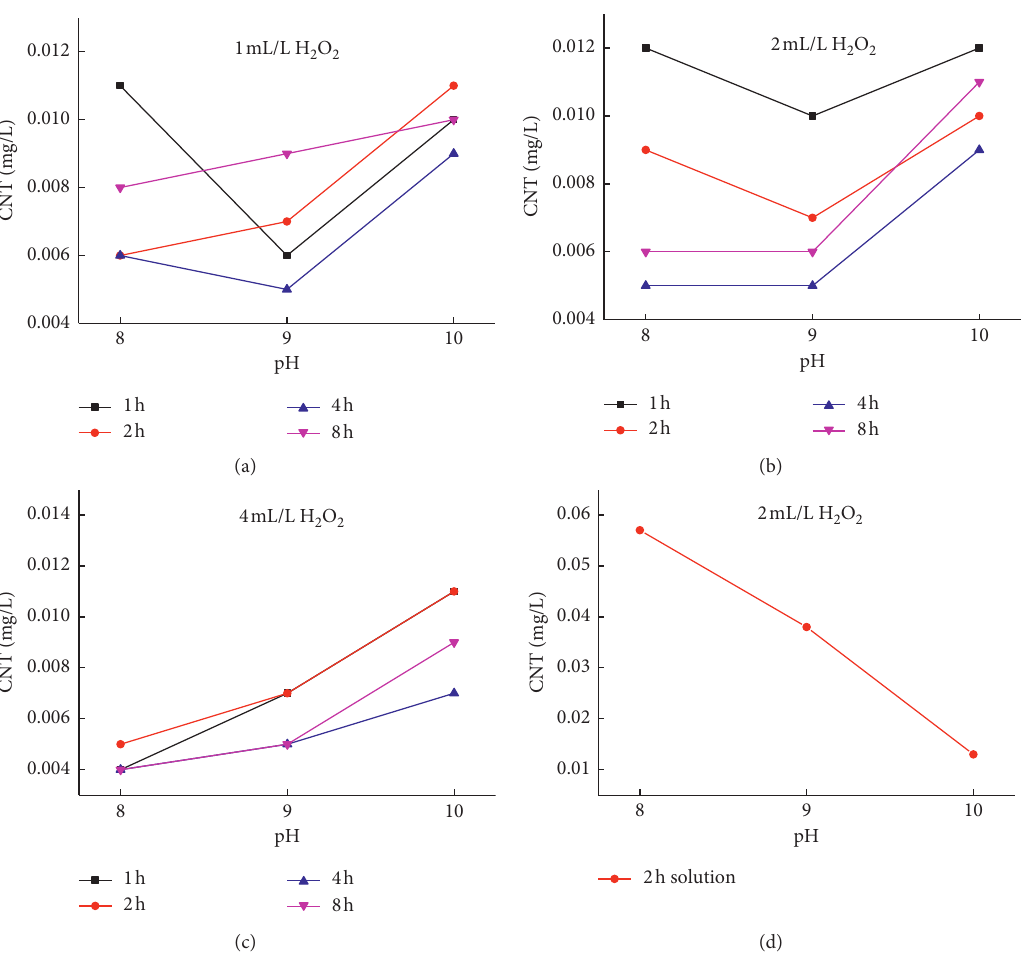
Figure 2: CNT as a function of pH in the presence of H